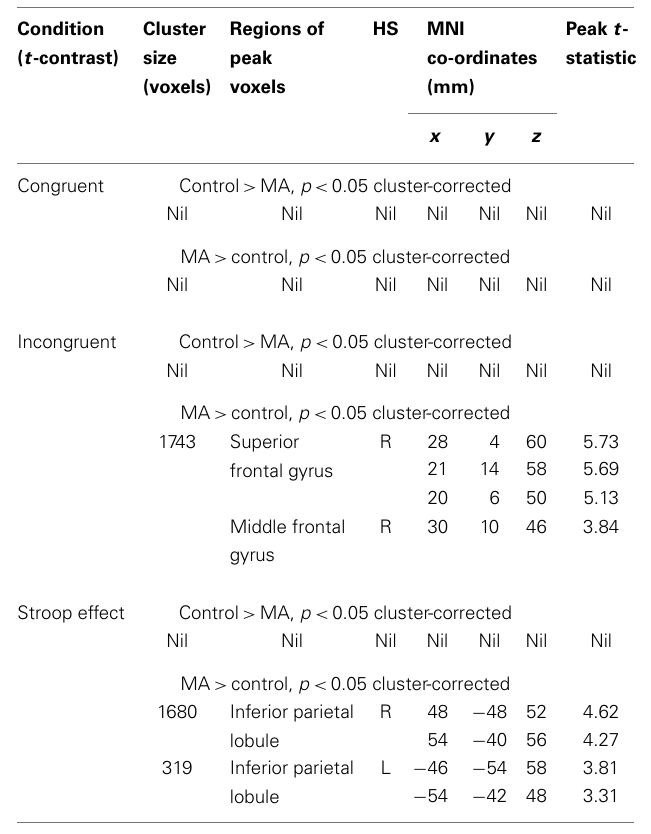
Table 4 |Whole-brain two-sample t -test analyses of group differences in blood-oxygen-level-dependent activation during the three Stroop conditions .